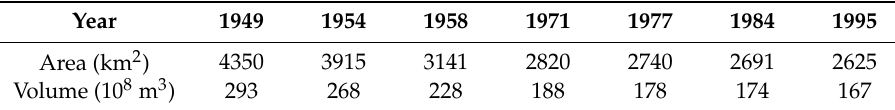
Table 1. The area and volume evolution of the